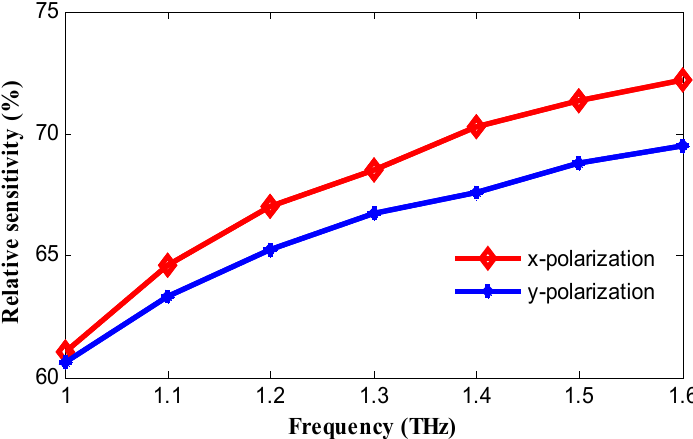
Figure 3. Relative sensitivity as a function of frequency when the core air holes were filled with water.